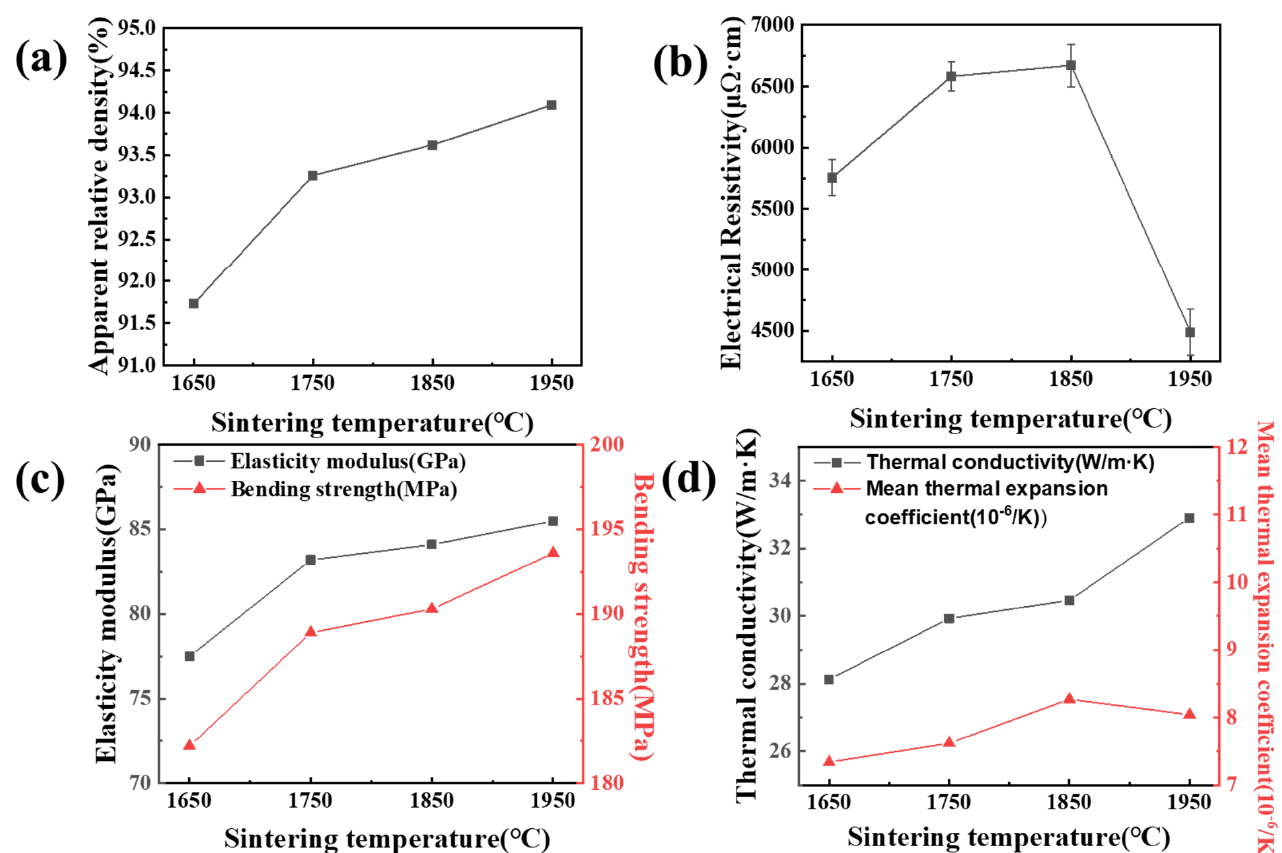
Figure 6. Properties of TiB 2 -BN-SiC composite ceramics at various sintering temperatures: ( a ) apparent relative density, ( b ) electrical resistivity, ( c ) elastic modulus and bending strength, and ( d ) thermal conductivity and mean thermal expansion coefficient.